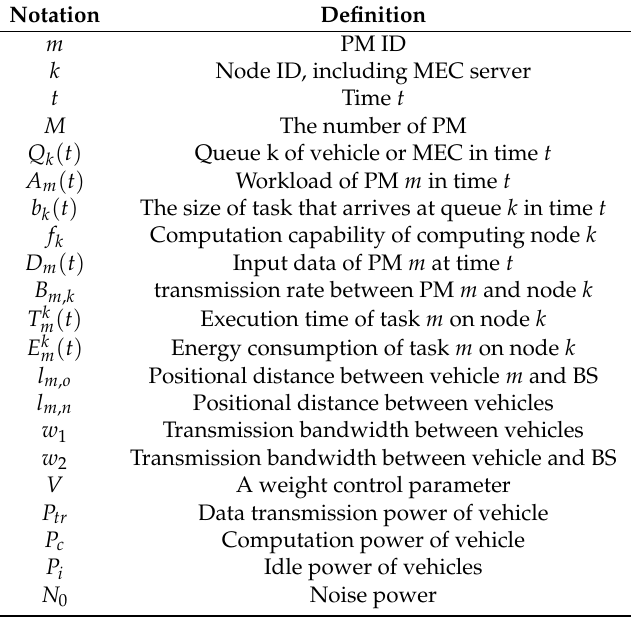
Table 1. Summary of key